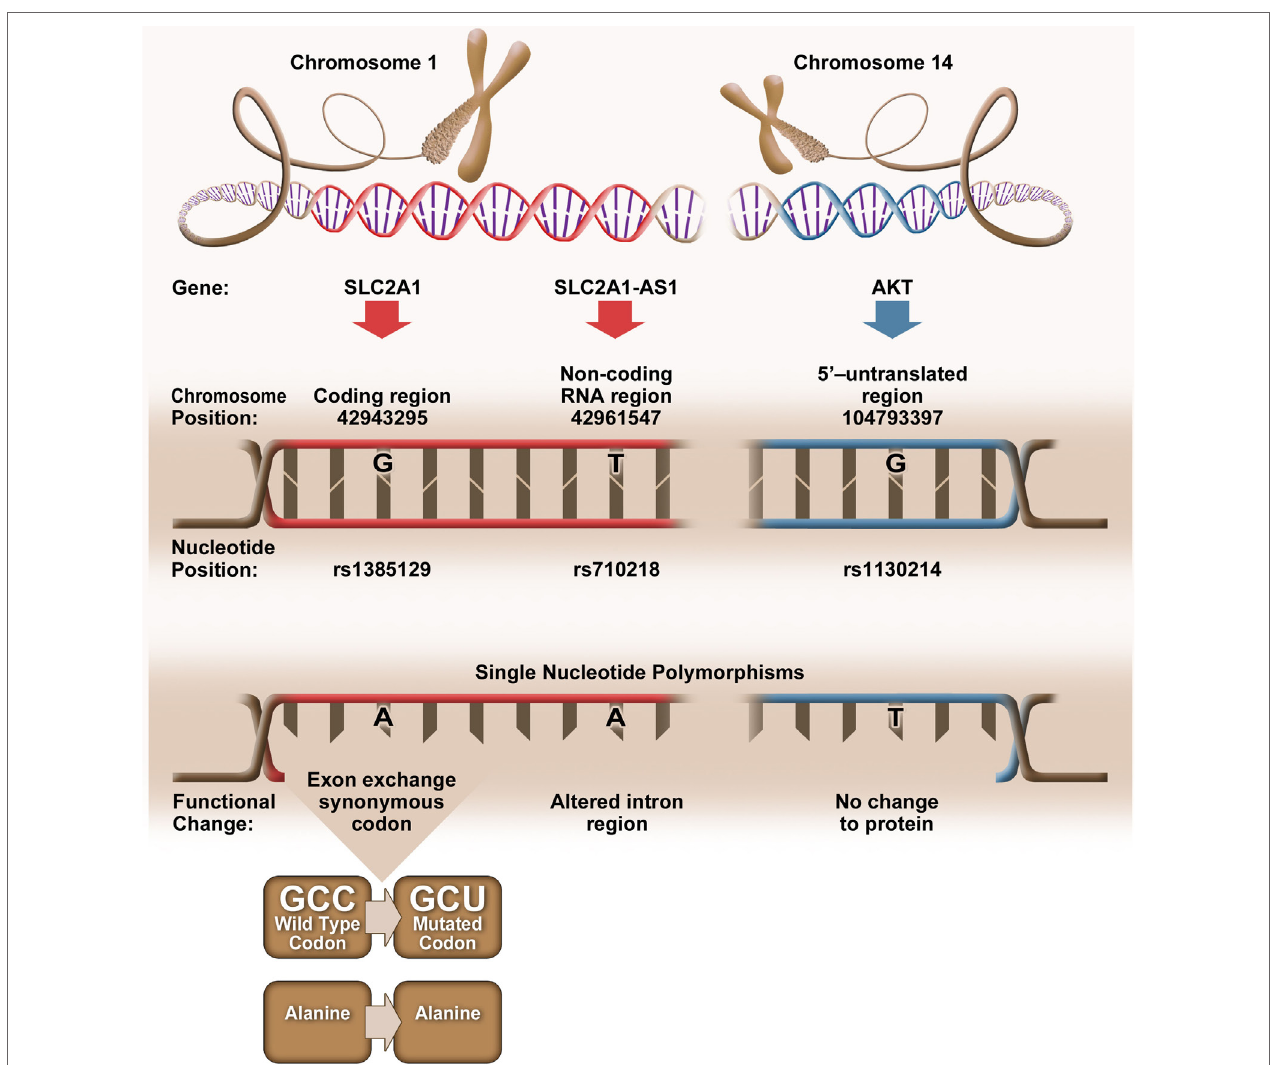
FigUre 4 | Genetic positioning and functional changes associated with SLC2A1 single nucleotide polymorphism (SNP) rs1385129 (73), SLC2A1-AS1 SNP rs710218 (74), and AKT SNP rs1130214